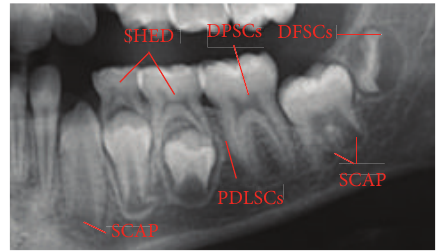
Figure 1: Dental stem cells’ sources.